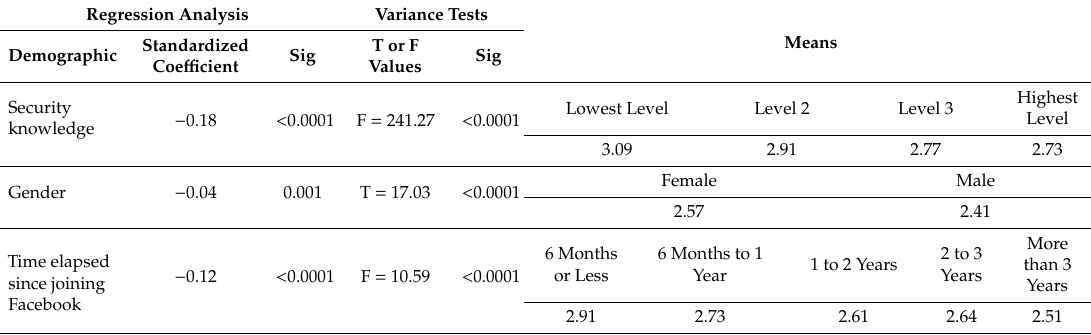
Table 8. Regression analysis for demographic groups and group di ff